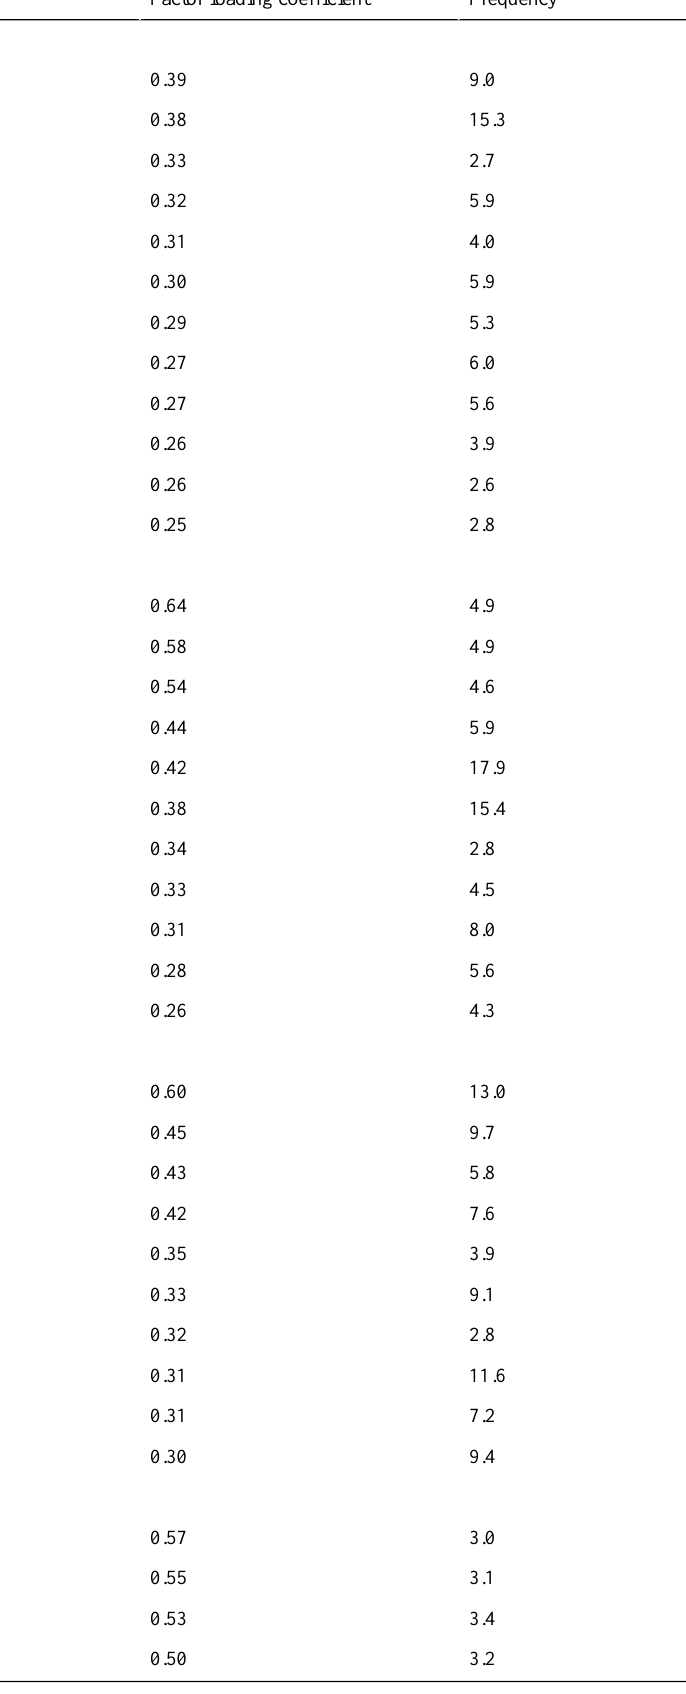
Table 2. Thematic clusters, word frequencies, and associated factor loading coefficients derived from the meaning extraction method with principal component analysis of comment posts from the Reddit community r/Testosterone